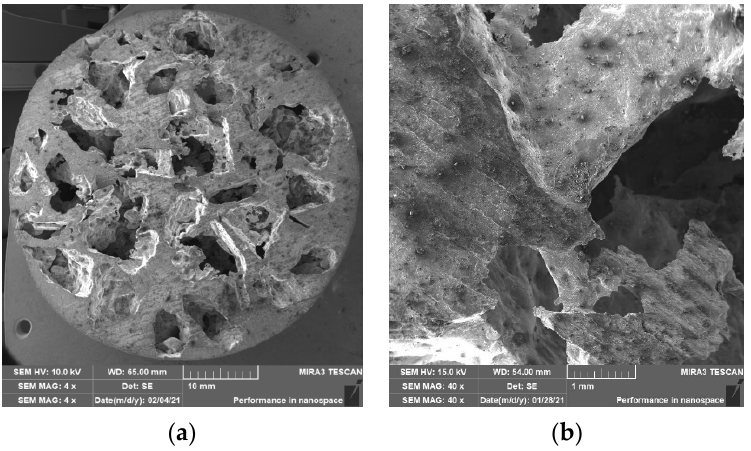
Figure 9. View of the structure of the porous material of AlSi12 alloy: ( a ) detail of the material; ( b ) scanning electron microscope image (Vega 3 Tescan, SEM HV 20.0 kV) of sample SAM1.